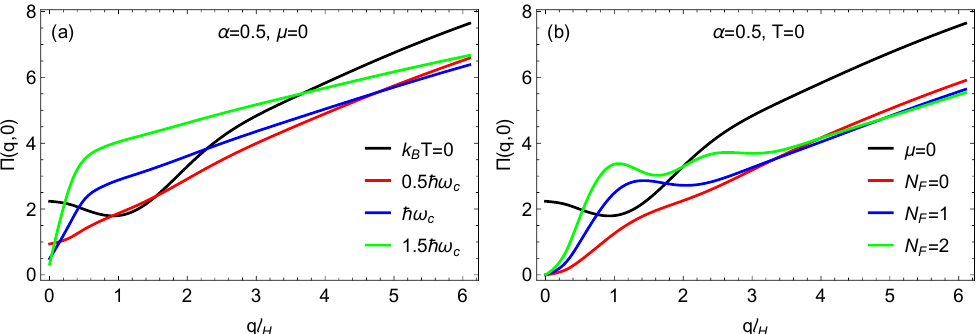
Figure 6. Plots for the static polarization function for ( a ) chosen µ = 0, as well as selected temper- atures and ( b ) zero temperature with filling factors N F , which is the index of the highest occupied Landau level at T = 0 K defining the chemical potentials. The magnetic length is denoted by l H and the cyclotron frequency by ω c .